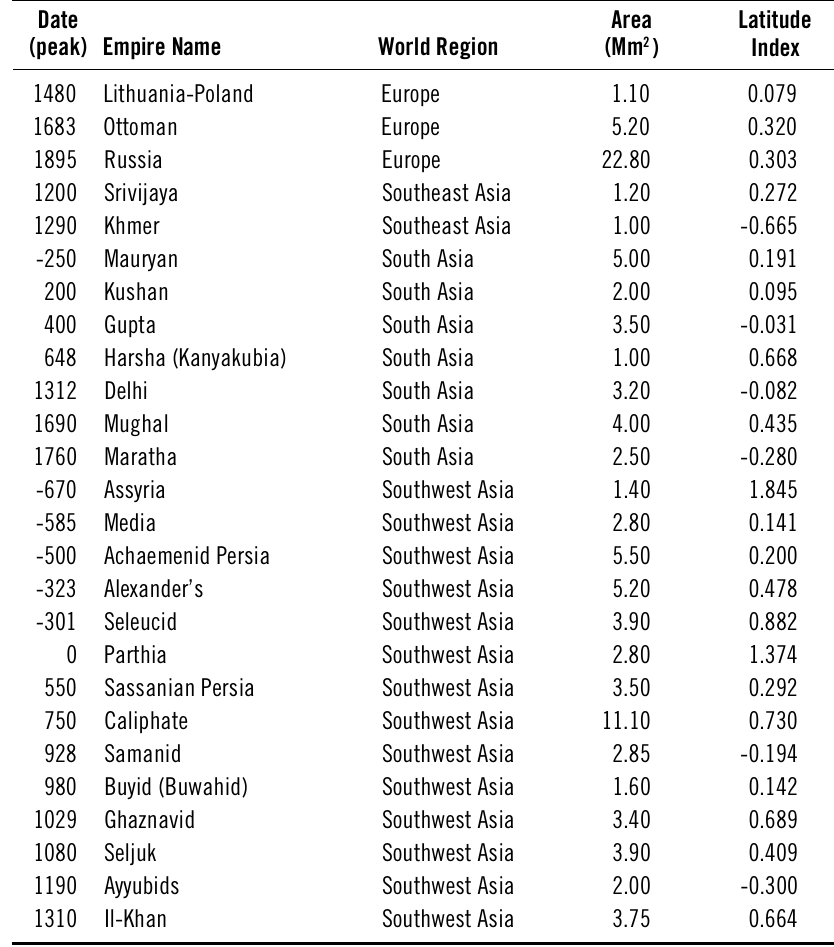
Our measure of the tendency to expand in the latitudinal direction is the